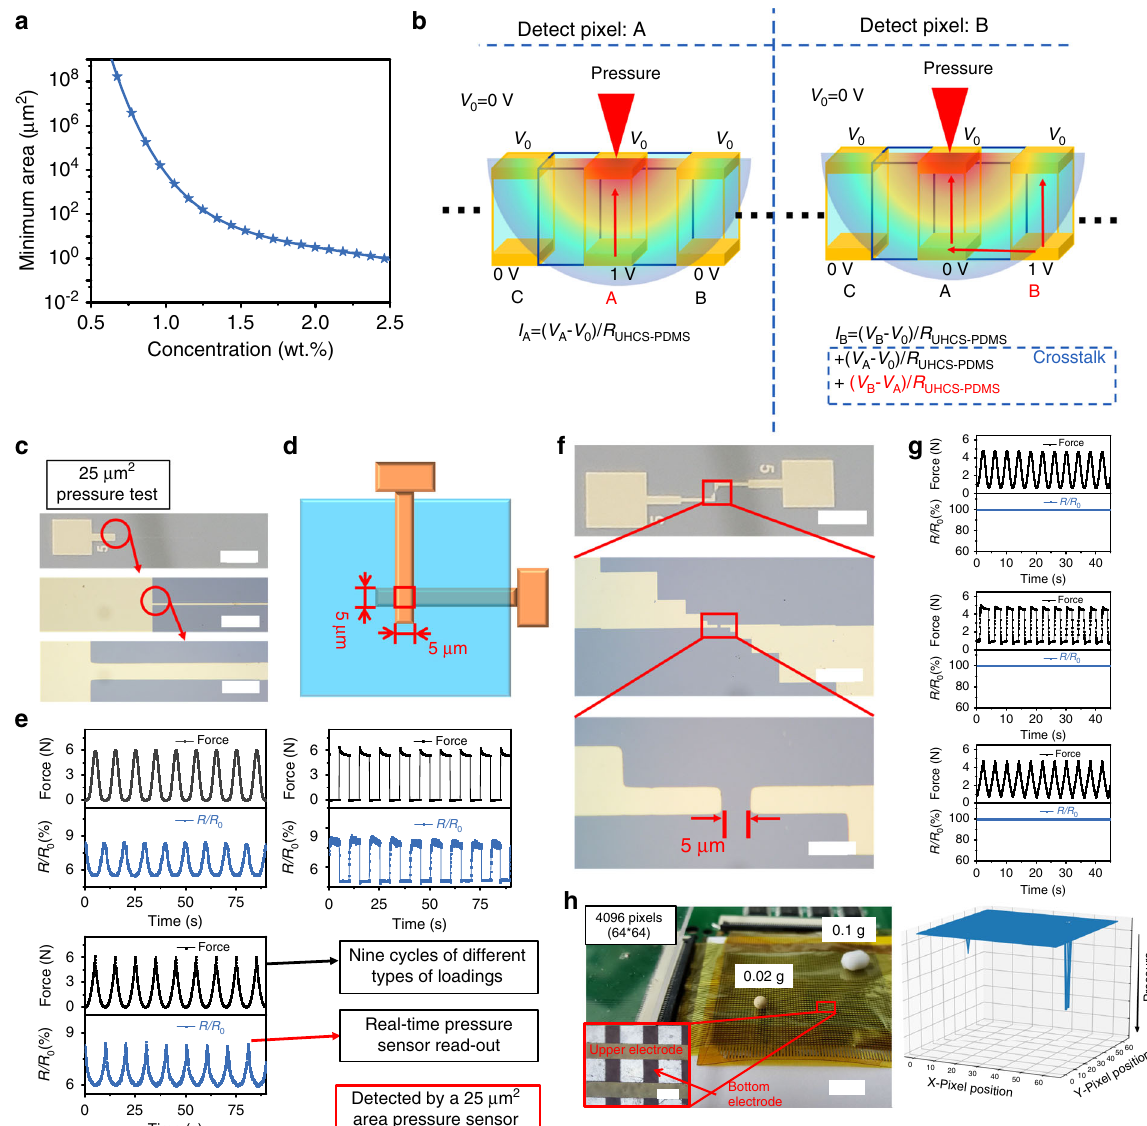
Fig. 5 Fabrication design and performance of the sensor array. a Relationship between the minimum detection area and the urchin-like hollow carbon sphere (UHCS) concentration. b Sketch of the crosstalk veri fi cation test. c Photographs of a 5- μ m-wide electrode used to form a 25 μ m 2 area pressure sensor. The scale bars are 2 mm, 100 μ m and 10 μ m. d Schematic diagram of the 25 μ m 2 sensor with crossed electrodes. e Three types (sine, rectangular, and triangular) of cyclic pressure applied in a real-time sensing test of the 25 μ m 2 pressure sensor shown in d . The black curve shows the loading force change with time, and the red curve shows the resistance change. f Photographs of two 5- μ m-wide electrodes used for the crosstalk veri fi cation test. The scale bars are 2 mm, 100 μ m, and 10 μ m. g Three types (sine, rectangular, and triangular) of cyclic pressure applied in a real-time sensing test of the veri fi cation test sensor shown in f . h Detection by a 64 × 64 pixel pressure sensor of two tiny balls of 0.02 and 0.1 g. Scale bars, 6.5 mm in the sensor photograph and 300 μ m in the magni fi ed optical